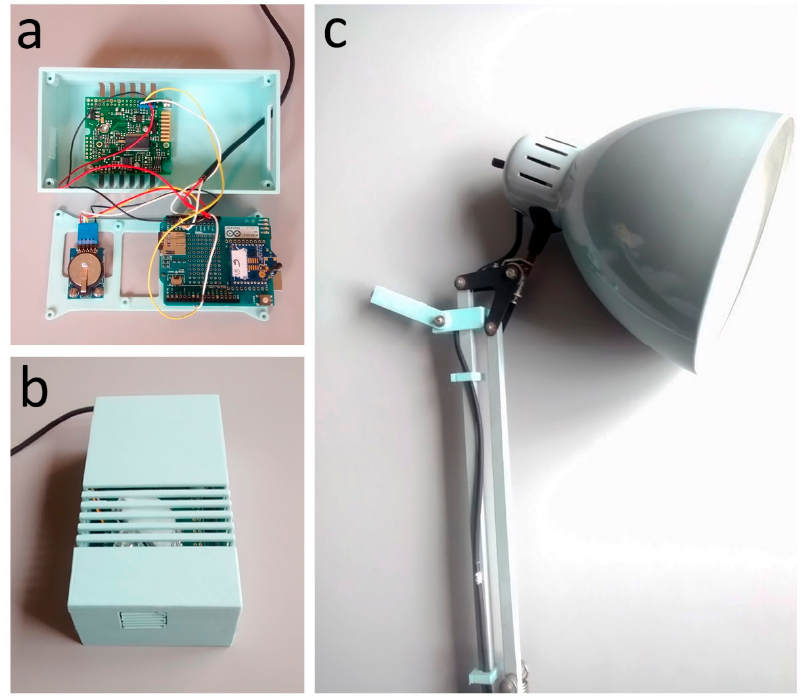
Figure 2. Nearable monitoring and coordination station: ( a ) internal connection; ( b ) external case with the slits for the CO 2 concentration sensor; ( c ) the lux sensor as mounted on the desk lamp.